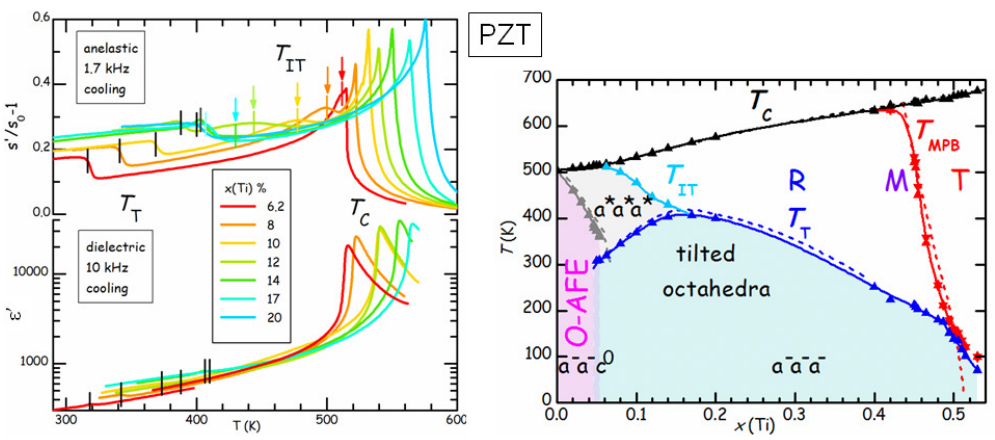
Figure 9. Elastic compliance and dielectric constant of various compositions of PZT. The coloured vertical bars indicated T C , the arrows T IT and the black arrows T T , which are plotted in the phase diagram on the right hand side as triangles, together with other compositions. The dashed lines are the generally reported phase diagram of PZT. The ferroelectric phases are R = rhombohedral, T = tetragonal, O-AFE = orthorhombic antiferroelectric. Also indicated are the octahedral tilt patterns (data from Ref.